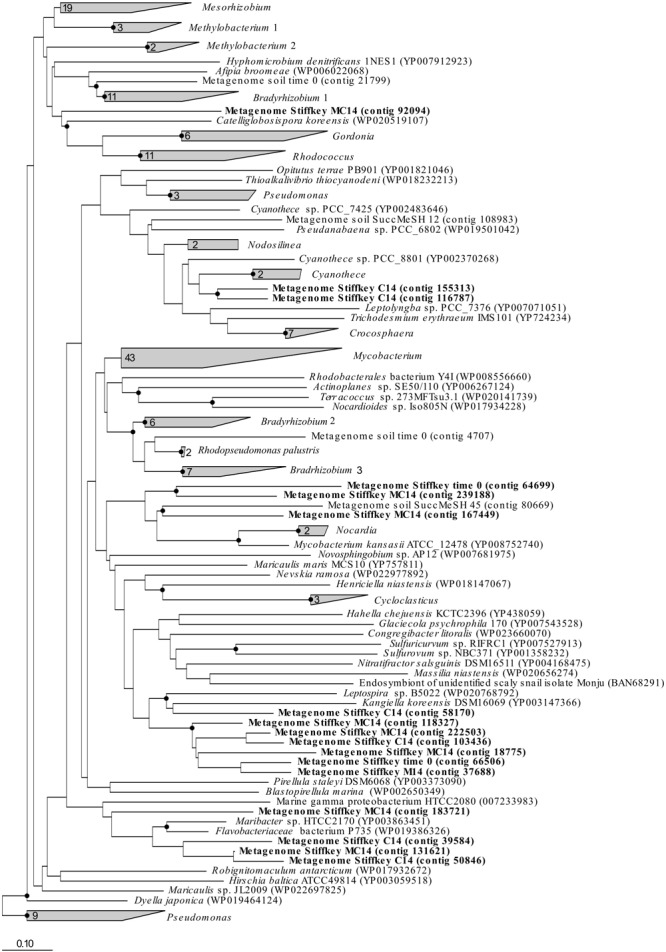
mddA RAxML phylogenetic tree including sequences retrieved from saltmarsh sediment assembled metagenomes. Environmental sequences obtained in this study are marked in bold. Time 0: sequences obtained from natural samples; M14: sequences retrieved from MeSH enrichments after 14 days of incubation; C14: sequences yielded by 14-day enriched samples with mixed carbon source; MC14: sequences obtained from enrichments with MeSH plus C after 14 days of incubation. Bar, 0.10 substitutions per amino acid position. Bootstrap values ≥ 70% (based on 100 replicates) are represented with dots at branch points.